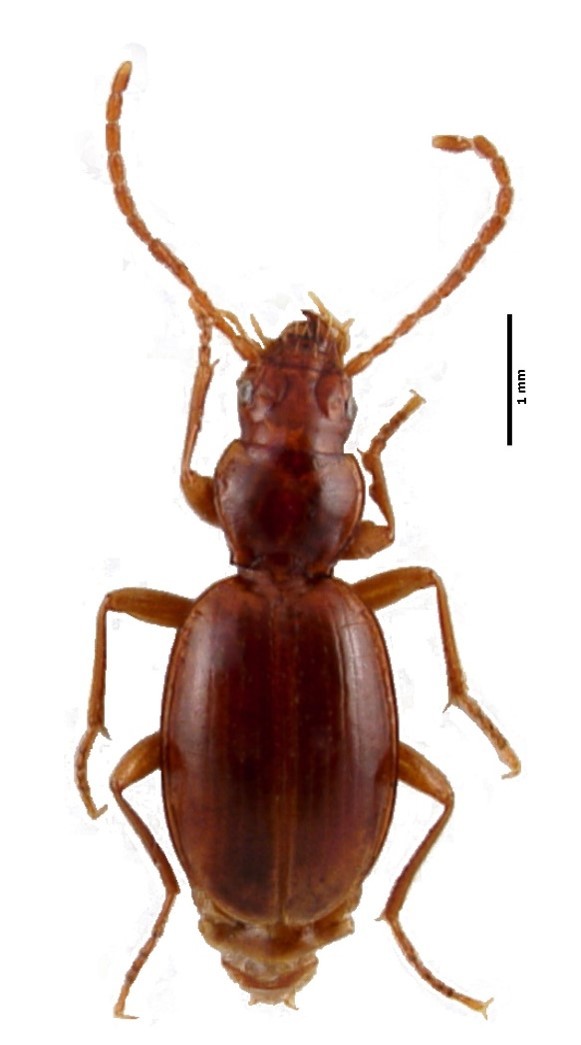
Trechus
montanheirorum (Oromí & Borges, 1991) from Pico island (Azores, Portugal) (Credit: Enésima Mendonça, Azorean Biodiversity Group, cE3c).